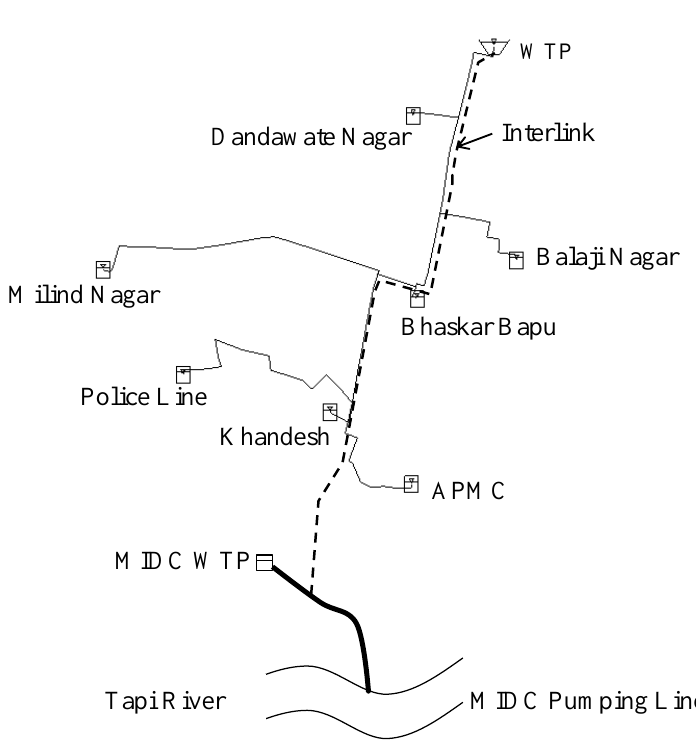
Fig. 2. Tapping of MIDC Water in disaster scenario using interlink